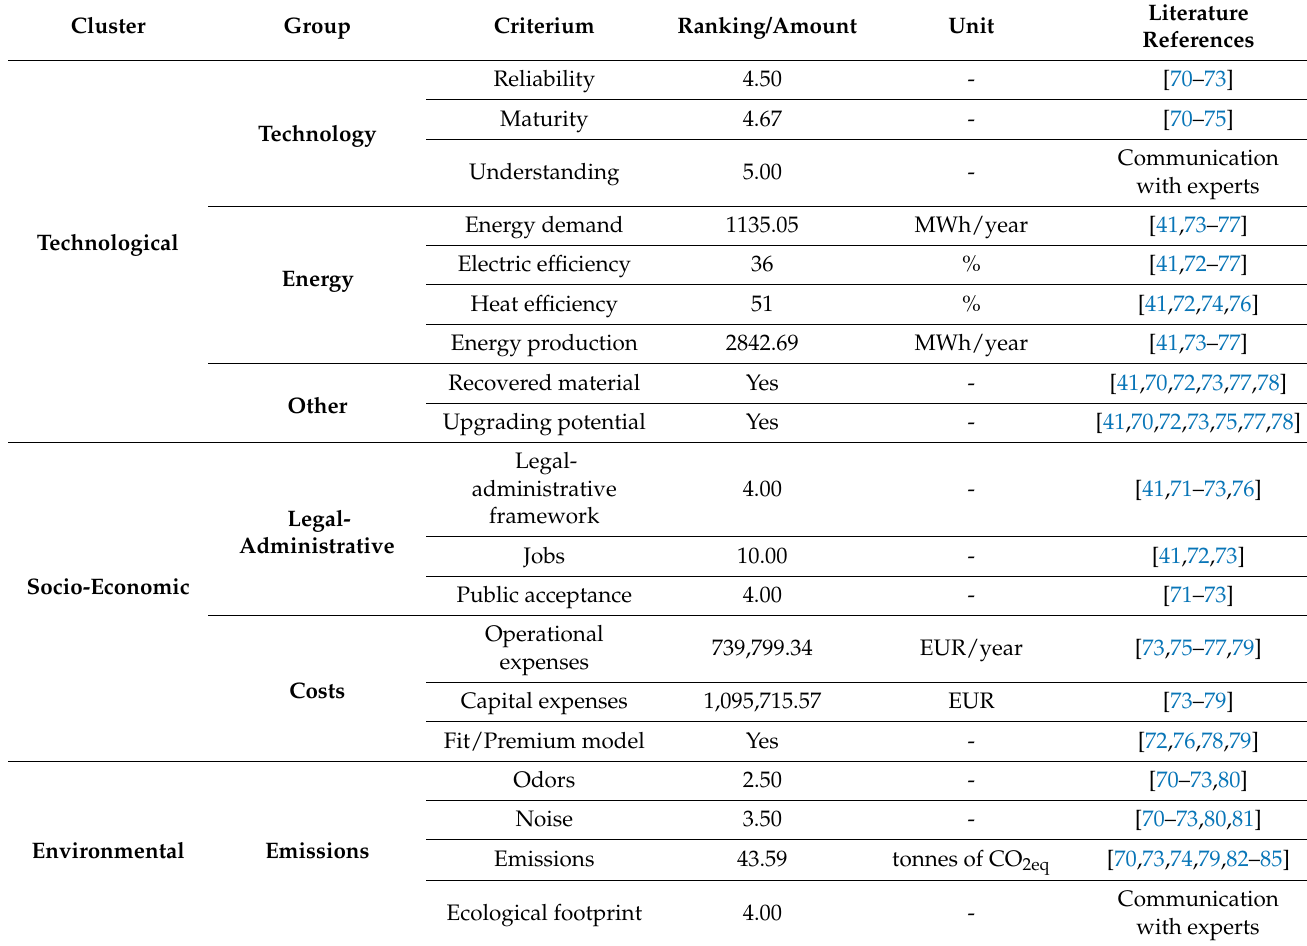
Table 4. Input data for the ranking of anaerobic digestion